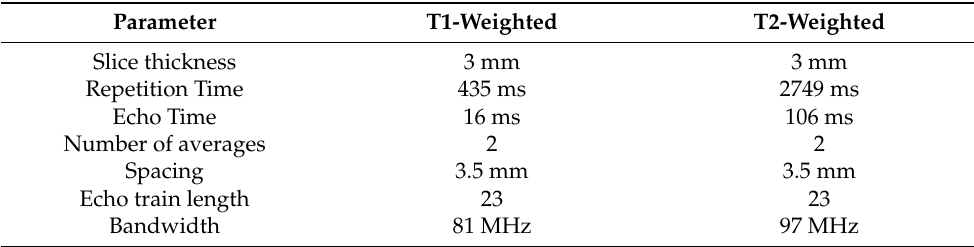
Table 1. Parameters used for acquisition of T1- and T2-weighted images. Parameter